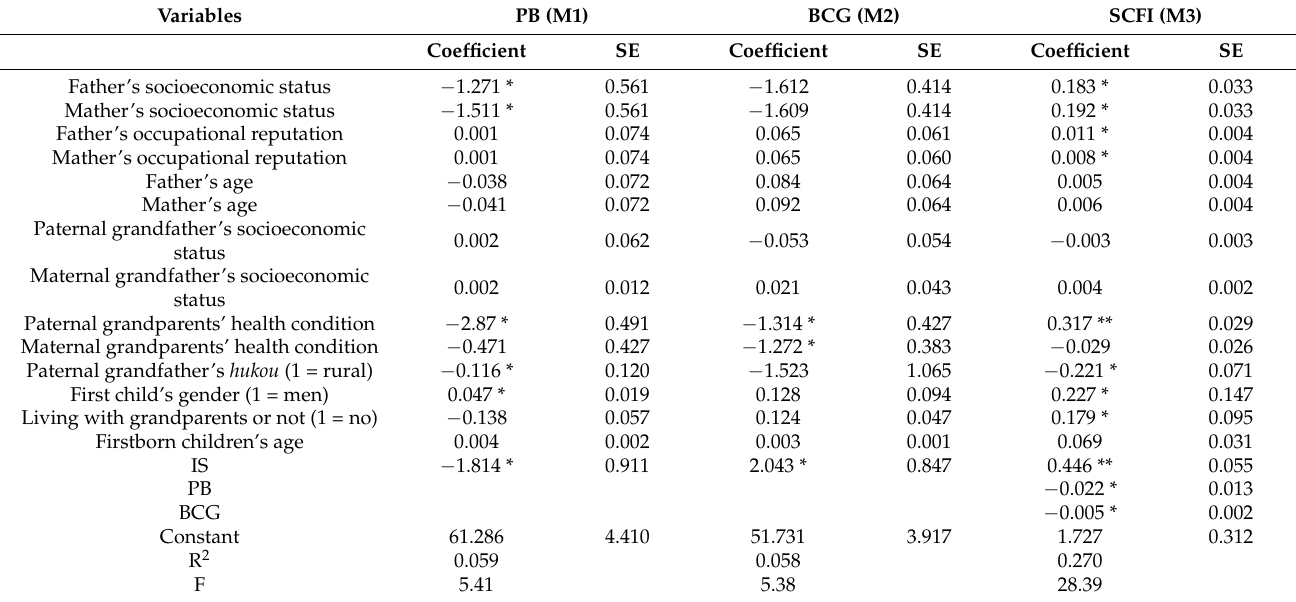
Table 4. Results of the regression analysis after